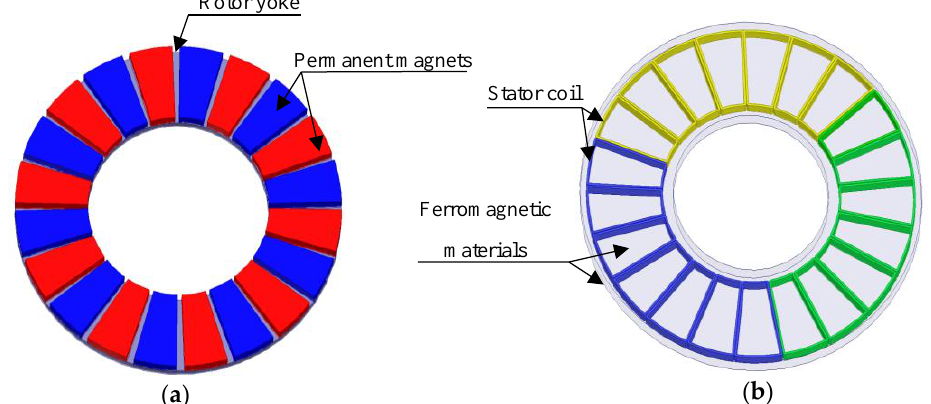
Figure 2. Structure of the ironless AFPMSG. ( a ) Rotor and permanent magnet (PM) structure; ( b ) Ironless stator structure.